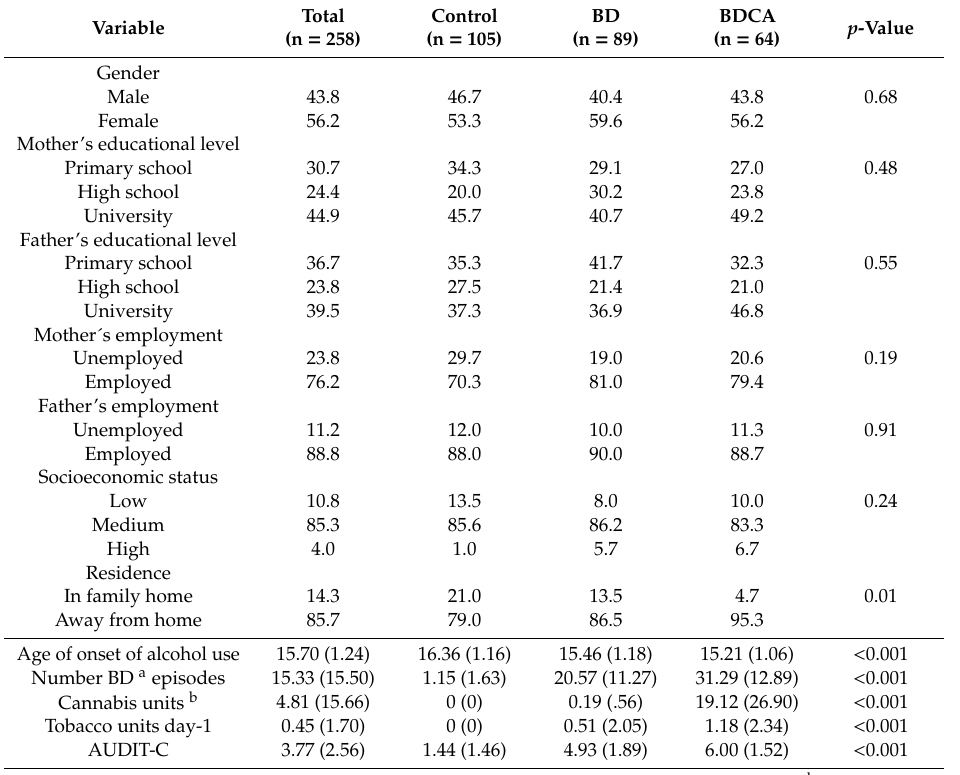
Table 1. Characteristics of the overall sample and each consumer group [% or M (SD), and p -values for comparative